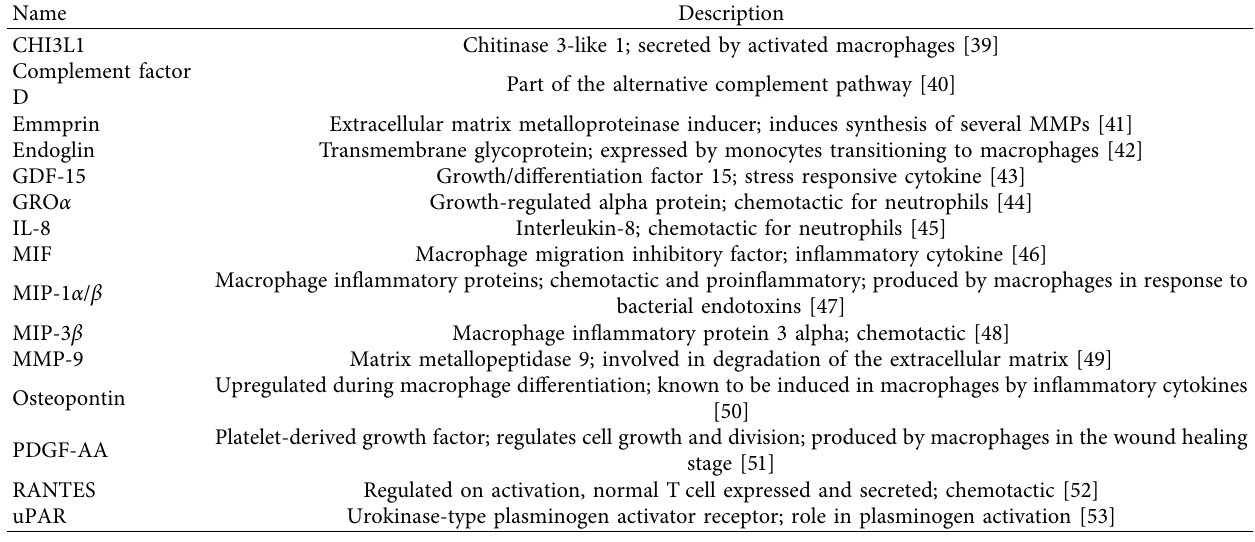
Table 2: Proteins detected using cytokine array assay.